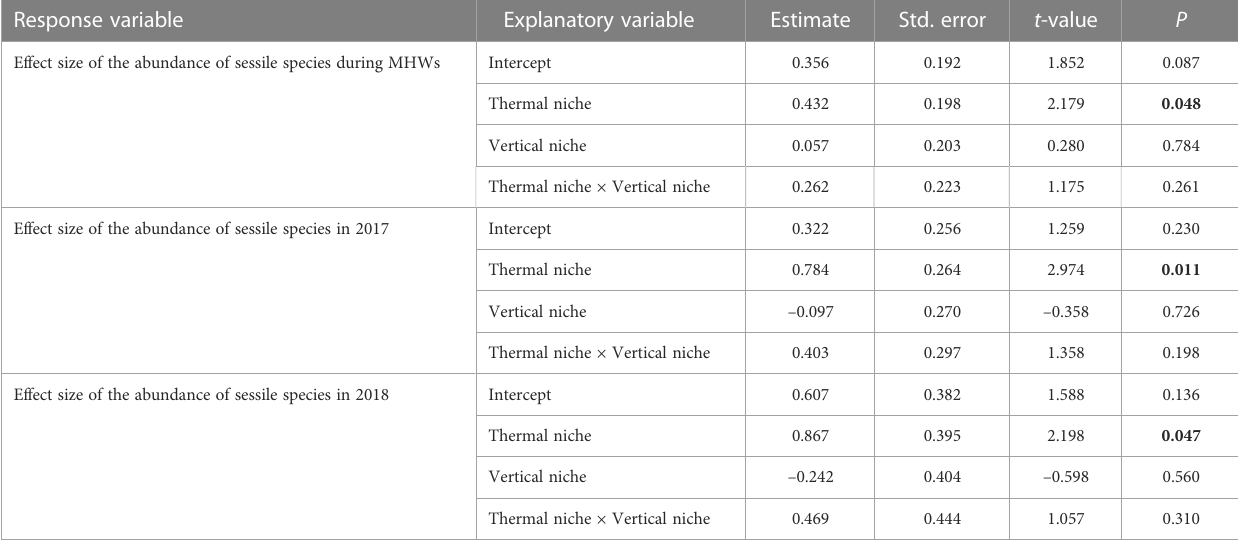
TABLE 4 Results of multiple regression analysis testing how the effects of MHWs on the abundance of each sessile species of rocky intertidal organism (macroalgae and sessile invertebrates) for each period differ depending on thermal and vertical